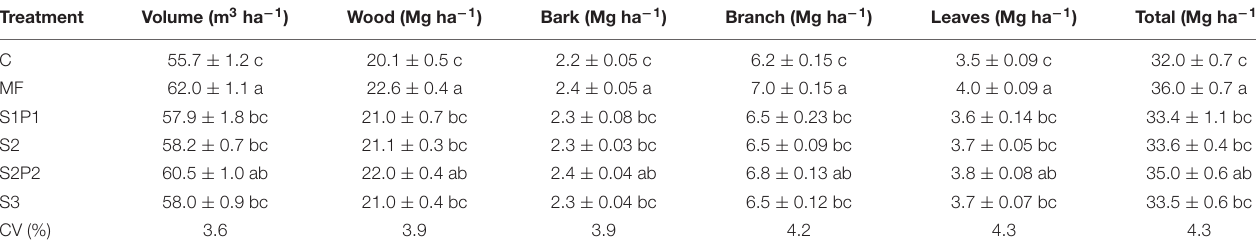
FIGURE 3 | Phosphorus in the microbial biomass (A) , at 0–5 cm horizon depth, and P availability, at 0–20 cm horizon depth, assessed by resin (B) in soil, 15 months after sewage sludge application (SS was applied 7 months after E. urograndis planting). C, control; MF, mineral fertilizer; S1P1, sludge (50%) + P (83%) + B + K; S2, sludge (100%) - P + B + K; S2P2, sludge (100%) + P (66%) + B + K; S3, sludge (150%) - P + B + K. Bars followed by the same letter do not differ by Duncan test ( p ≤ 0.05). Vertical lines on bars represent standard error ( n = 4). TABLE 4 | Production of 22-month-old E. urograndis plantation in a soil treated with class B sewage sludge 7 months after planting (mean ± standard error, n = 4).